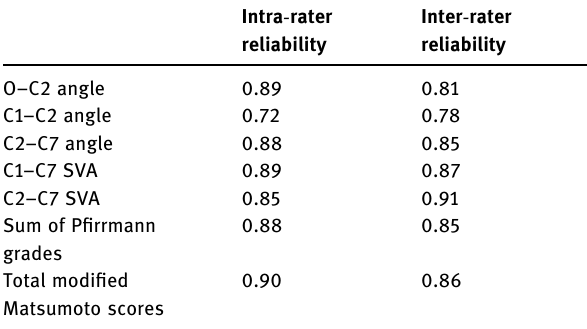
Table 2: Intra - rater and inter - rater reliability for all subjects Intra -